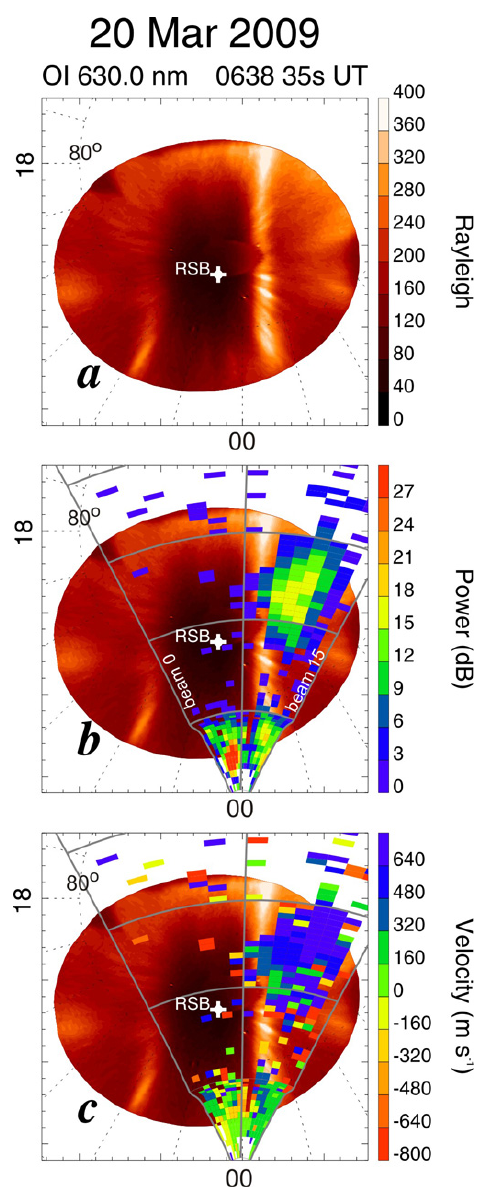
Fig. 9. (a) Optical image of the polar cap arc for the event of 20 March 2009, 06:38UT. Mapping is done in MLAT-MLT coordi- nates. Panels (b) and (c) show the same image with overlaid Rankin Inlet radar maps of the echo power and velocity, respectively. Range ticks within the radar field-of-view correspond to gates 15, 30, 45 and